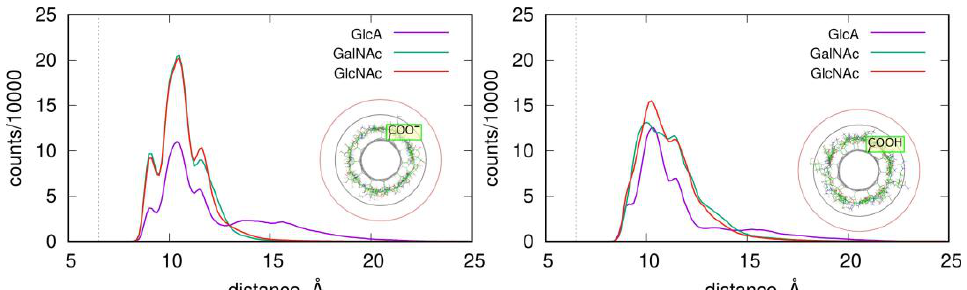
Figure 4. RDF of the GlcA, GalNAc and GlcNAc monosaccharides adsorbed on the fCNT surfaces as a function of the distance from the fCNT axis. The dashed vertical lines show the position of carbon atoms within the nanotube. The concentric black and red circles show the 15 Å and 20 Å distances, respectively, from the fCNT axis using the last MD simulation frames from GlcNAc systems as background images. The number of counts reports the number of times a given distance was detected during the production run.